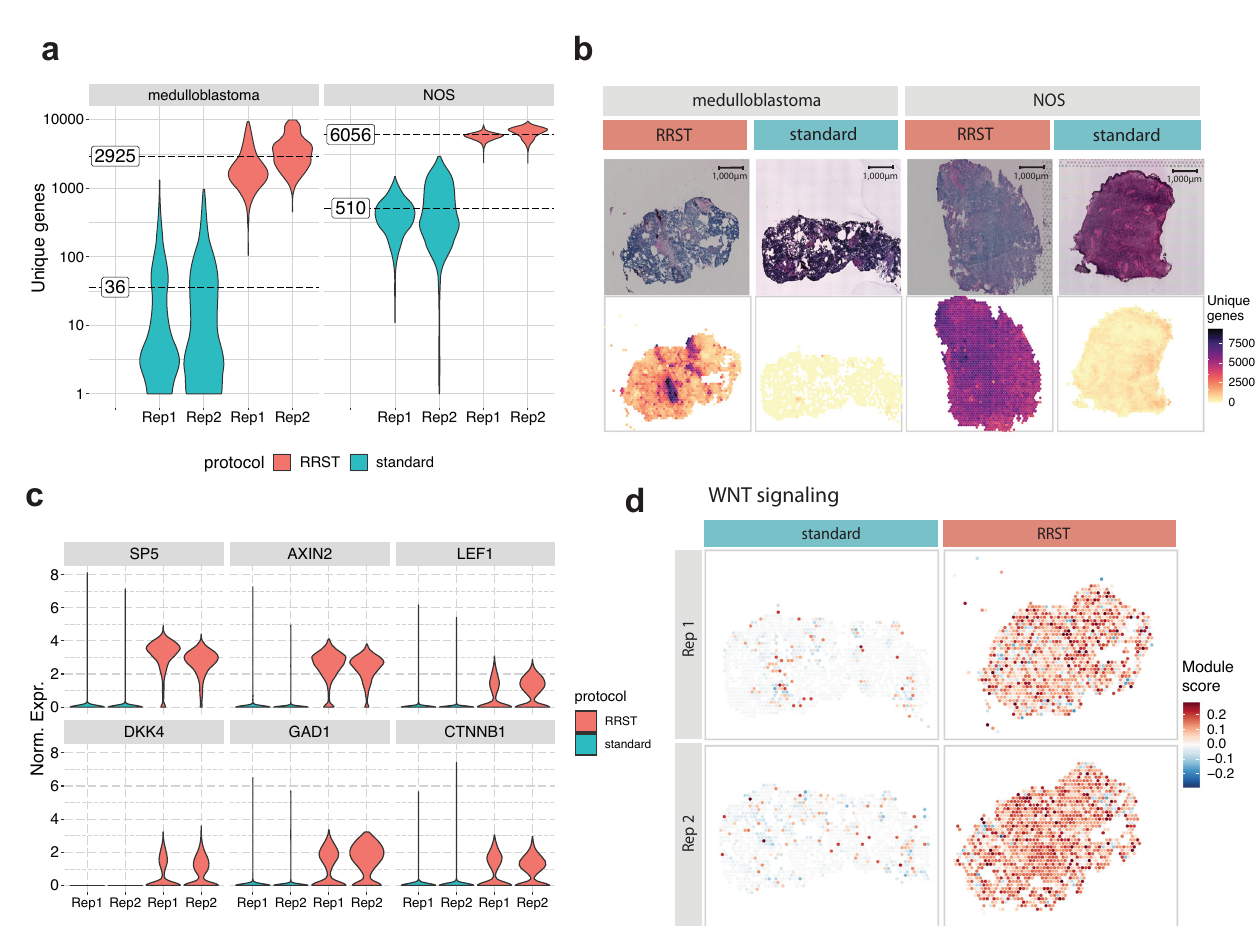
Fig. 4 | Comparison between RRST and standard Visium on an adult human small intestine sample over time. a Representative H&E image (top) and spots colored by fi ve major tissue regions (bottom): mucosa, TLS, submucosa, muscu- laris, and serosa. TLS, Tertiary Lymphoid Tissue. The full small intestine dataset consisted of 14 tissue sections collected from the same specimen at different time points. Only sections collected at the last point were processed with RRST, while the other sections were processed with standard Visium protocol. b Overview of dataqualityinthe fi veannotatedtissueregionsovertime,visualizedbyviolinplots of the number of unique genes per spot. The time points represent the approx- imate storage time after sample collection: ~1 month, ~6 months, and ~2 years. Replicatesobtainedforeachtimepointareshownonthe x -axis.The fi llcolorofthe violin plots indicates the applied protocol. For each time point, labels on the left